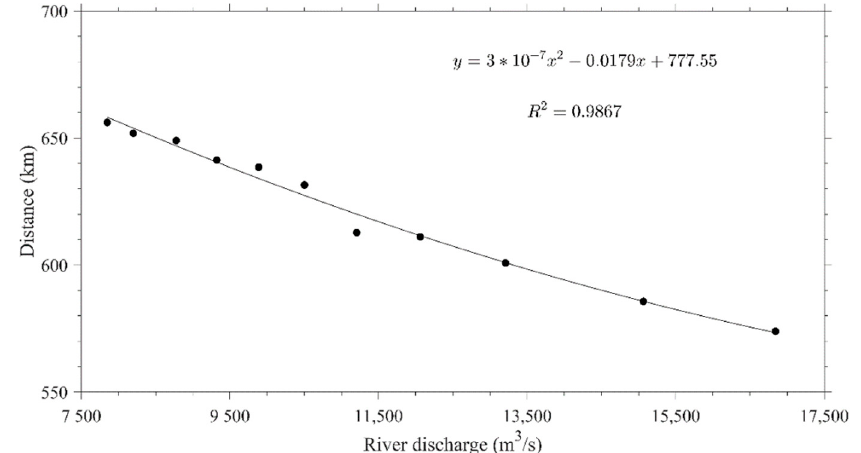
Figure 11. Relationship between the tidal level limit and river discharge in the Changjiang River’s estuary in the dry season.